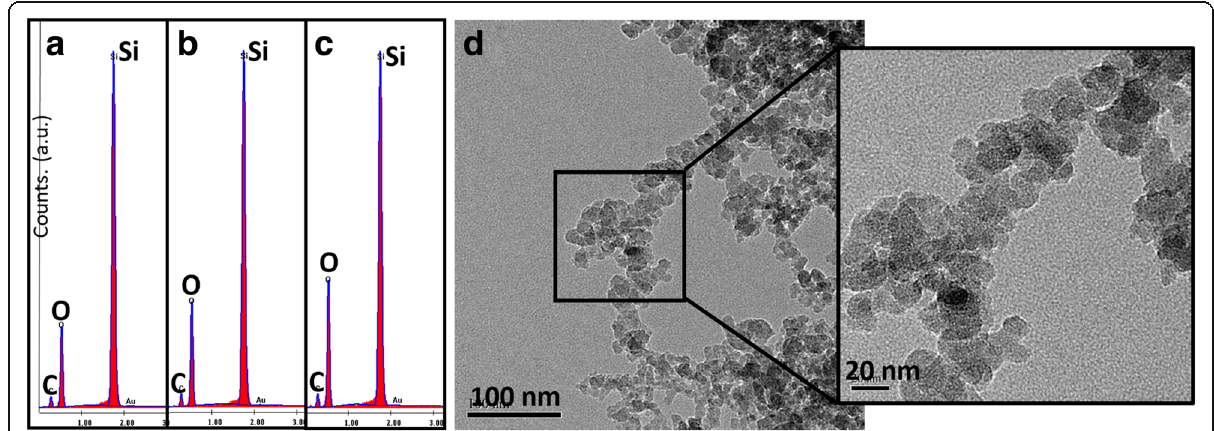
Fig. 8 EDX images of laser processed silicon at 0.025 mm. a 1 OL, b 3 OL, c 5 OL, d TEM of sample prepared at five overlaps